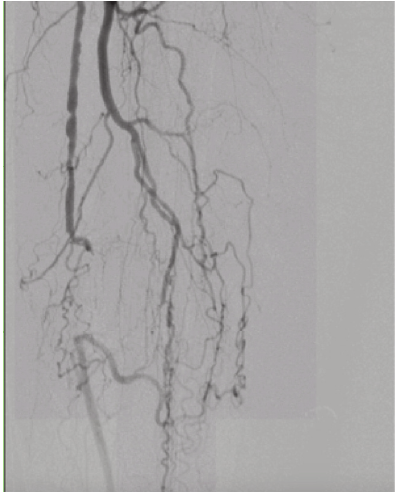
Figure 3: A retrograde self-expanding stent.